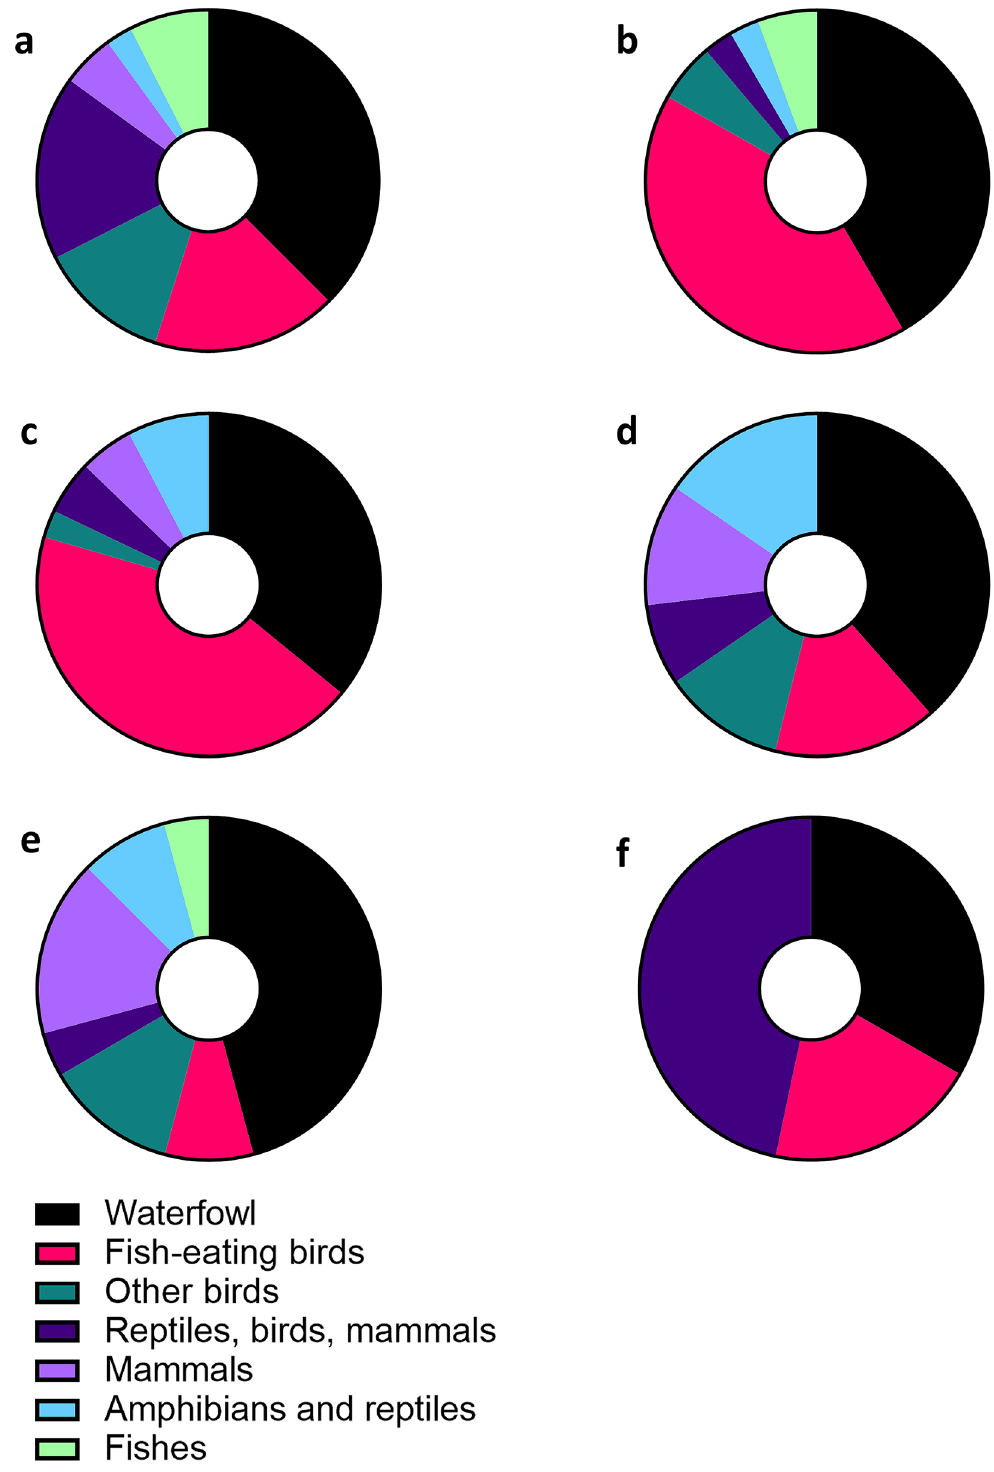
Figure 5. Proportion of final hosts. ( a ) Central European natural reserve. ( b ) Central European reservoirs. ( c ) Northern American lakes. ( d ) Central European fish ponds. ( e ) Central European lakes. ( f ) Northern European